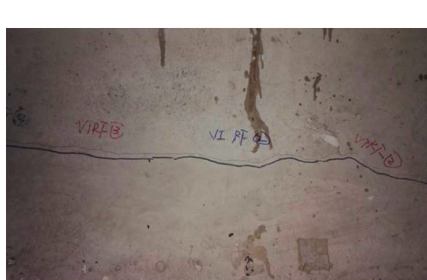
Figure 19: Destruction diagram of the right arch foot of the tunnel entrance